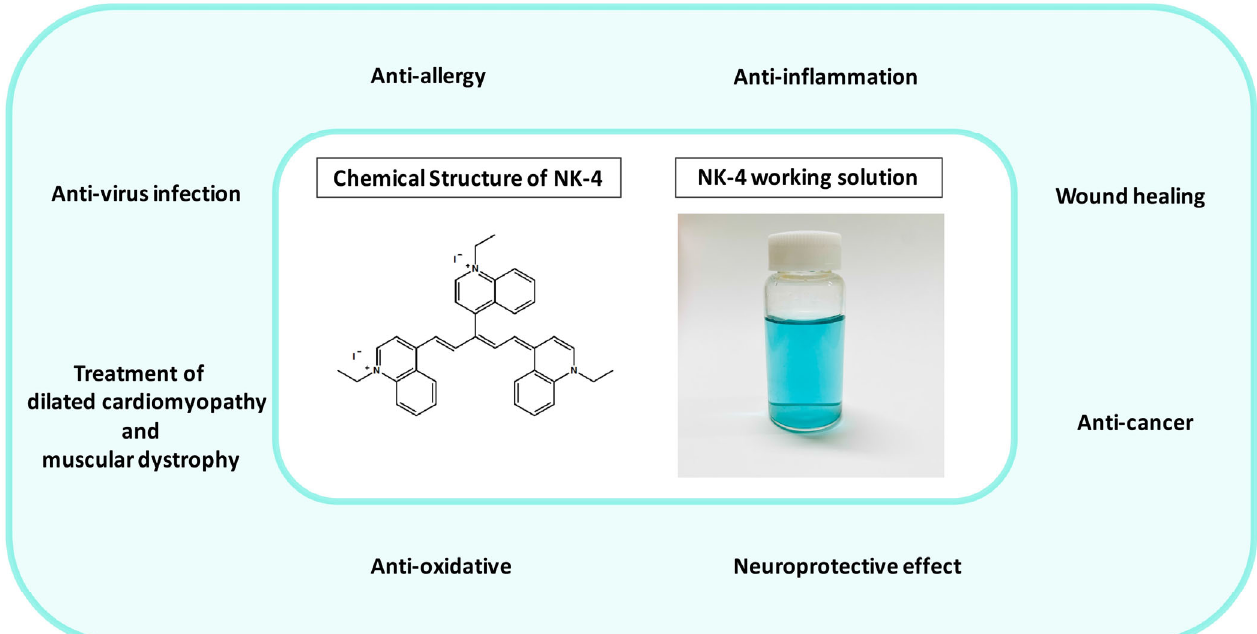
Figure 1. Fields of application of NK-4 (in the green circle), chemical structure of NK-4, and NK-4 working solution (0.01 mg/mL).